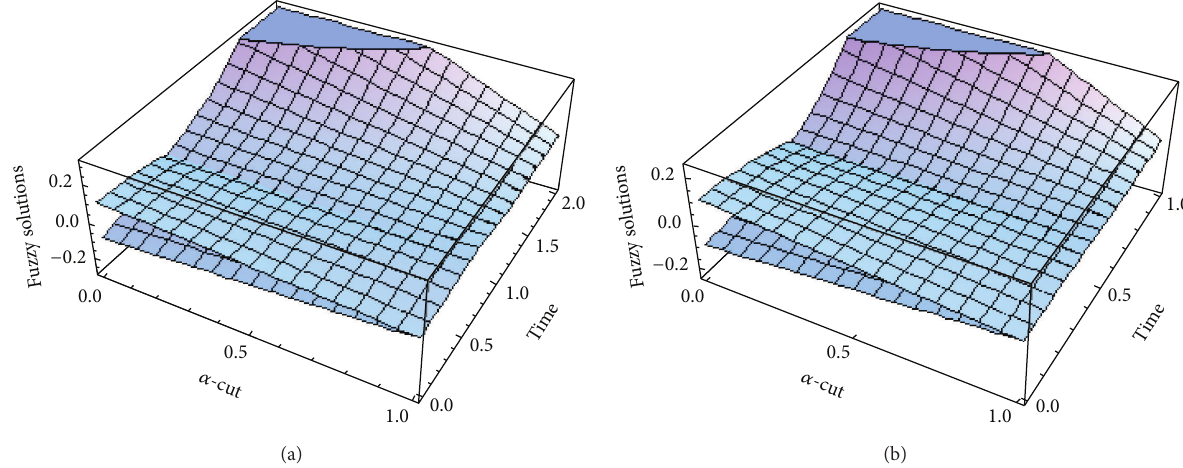
Figure 1: Fuzzy responses at 𝑥 = 1/2 with natural frequency (a) 𝜔 = 5 rad/s and (b) 𝜔 = 10 rad/s and damping ratio 𝜂 = 0.05 for unit step response.